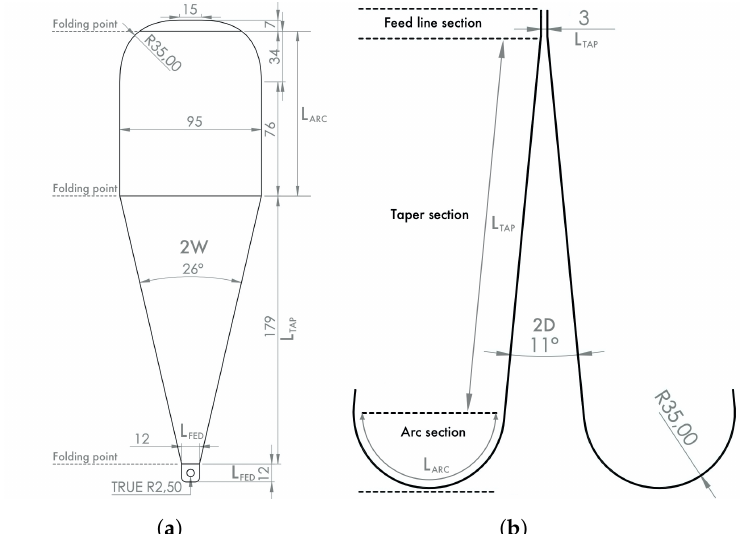
Figure 3. ( a ) Top view of the VH antenna dimension, when the part is flattened; ( b ) side view of antenna assembly and given flattening parameters (the given values are expressed in mm)